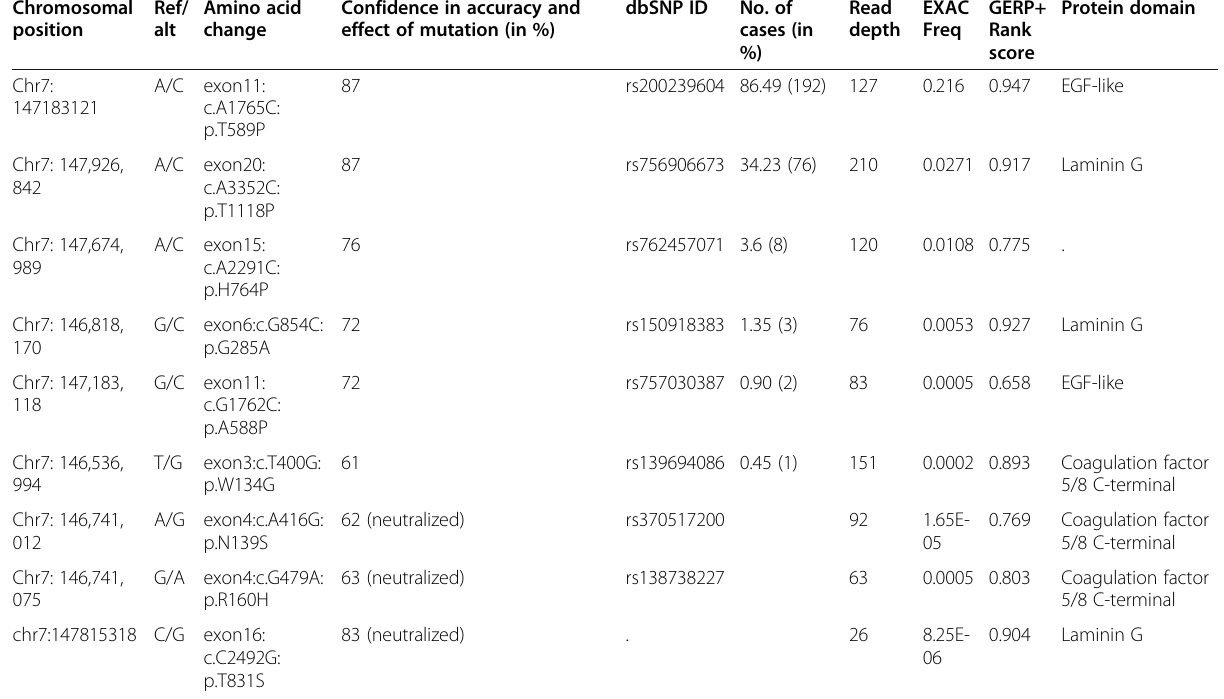
Table 2 Overlapping CNTNAP2 variants for the transcript NM_014141 positioned on chromosome 7 across multiple whole-exome sequence datasets for the current investigation Chromosomal